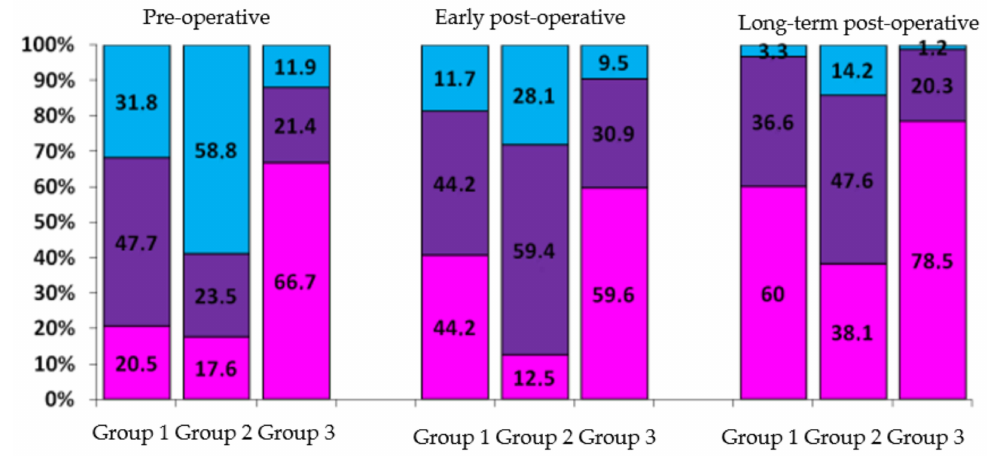
Figure 7. Analysis of heart geometry restoration according to types of initial pathology remodeling (in %). Group 1—patients with mitral valve stenosis and 1st or 2nd degree of mitral regurgitation. Group 2—patients with mitral valve stenosis and 3rd or 4th degree of mitral regurgitation. Group 3—patients with isolated organic mitral valve insu ffi ciency. Pink color: share of patients with Type I remodeling; purple color: share of patients with Type II remodeling; blue color: share of patients with Type III remodeling.